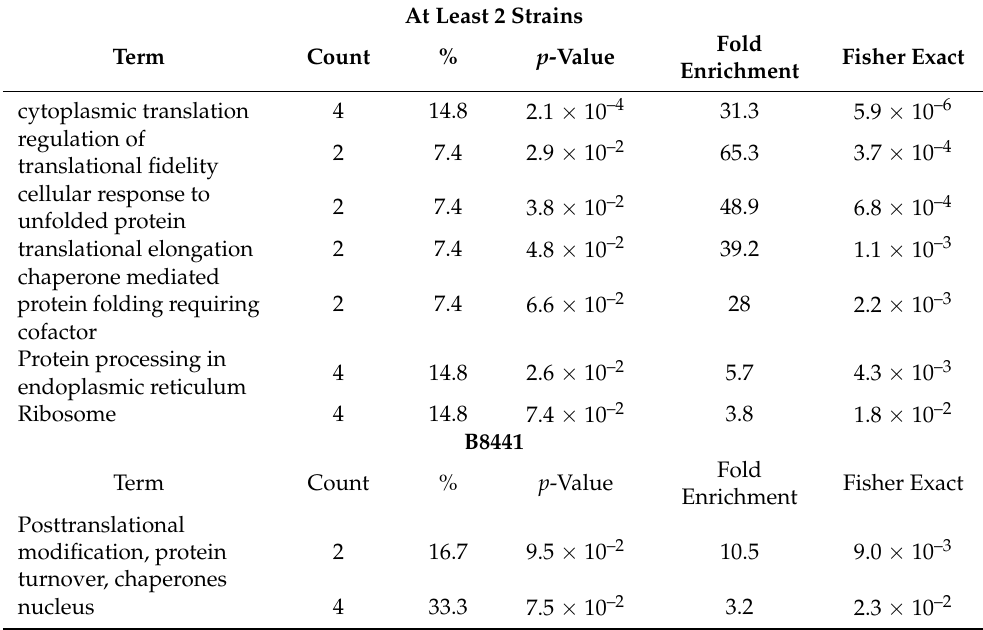
Figure 2. mRNAs present in C. auris EVs. ( A ) Reads coverage profile of transcripts enriched in EVs isolated after caspofungin treatment; forward reads (green), reverse reads (red) and non-specific match (yellow). ( B ) Venn chart of the mRNAs present in the EVs from the strains used in this study. ( C ) Gene ontology bubble chart, with the common transcripts identified in the EVs from the three strains, with the terms enriched in the presence of caspofungin. X -axis, the number of counts for the terms identified, Y -axis, the percentage of terms in the analysis; the bubble size reflects the fold-enrichment of the term after Fisher-exact test was applied and the color code reflect the p -value of the terms. Table 1. Gene ontology terms of EV-mRNAs enriched upon caspofungin treatment in at least two strains (top) or exclusive to B8441 strain